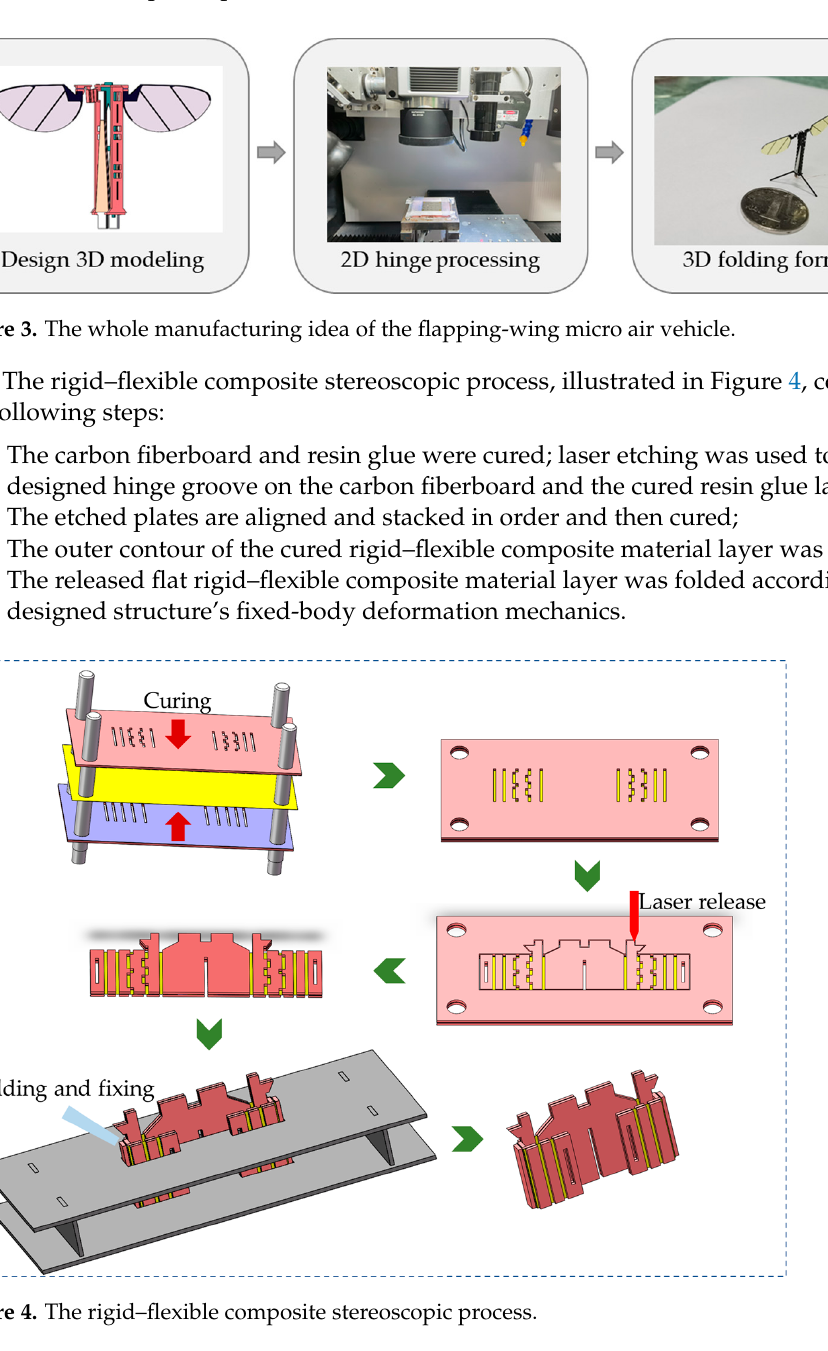
Figure 4. The rigid–flexible composite stereoscopic process.